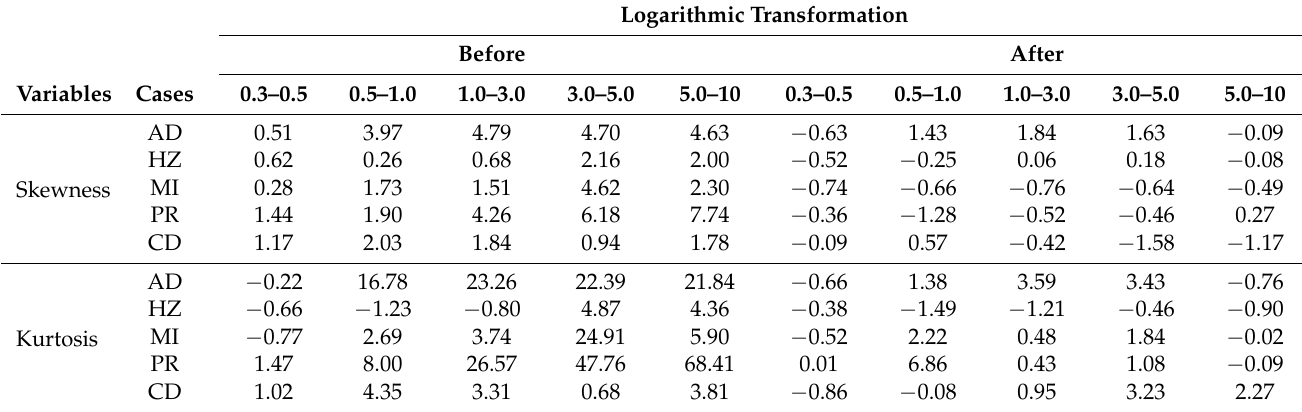
Table 3. Skewness and Kurtosis for the aerosol mass concentration by particle size before and after logarithmic transformation for the instances of meteorological phenomena.